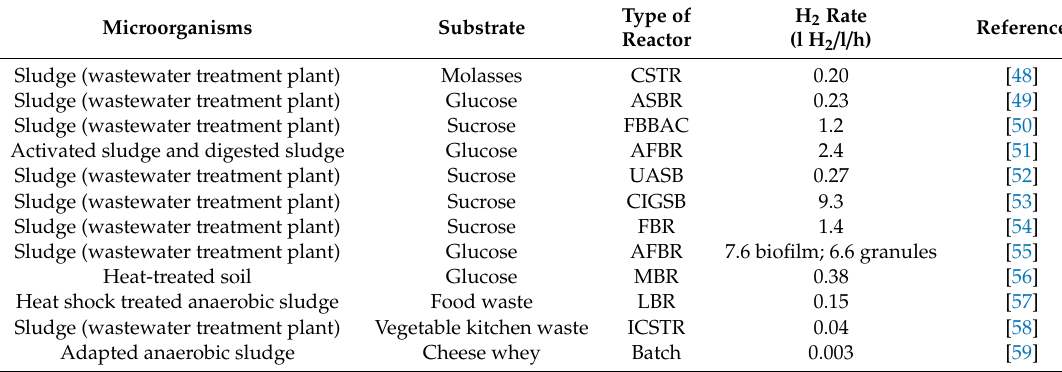
Table 1. Dark fermentation bioreactors used for H 2 production with di ff erent